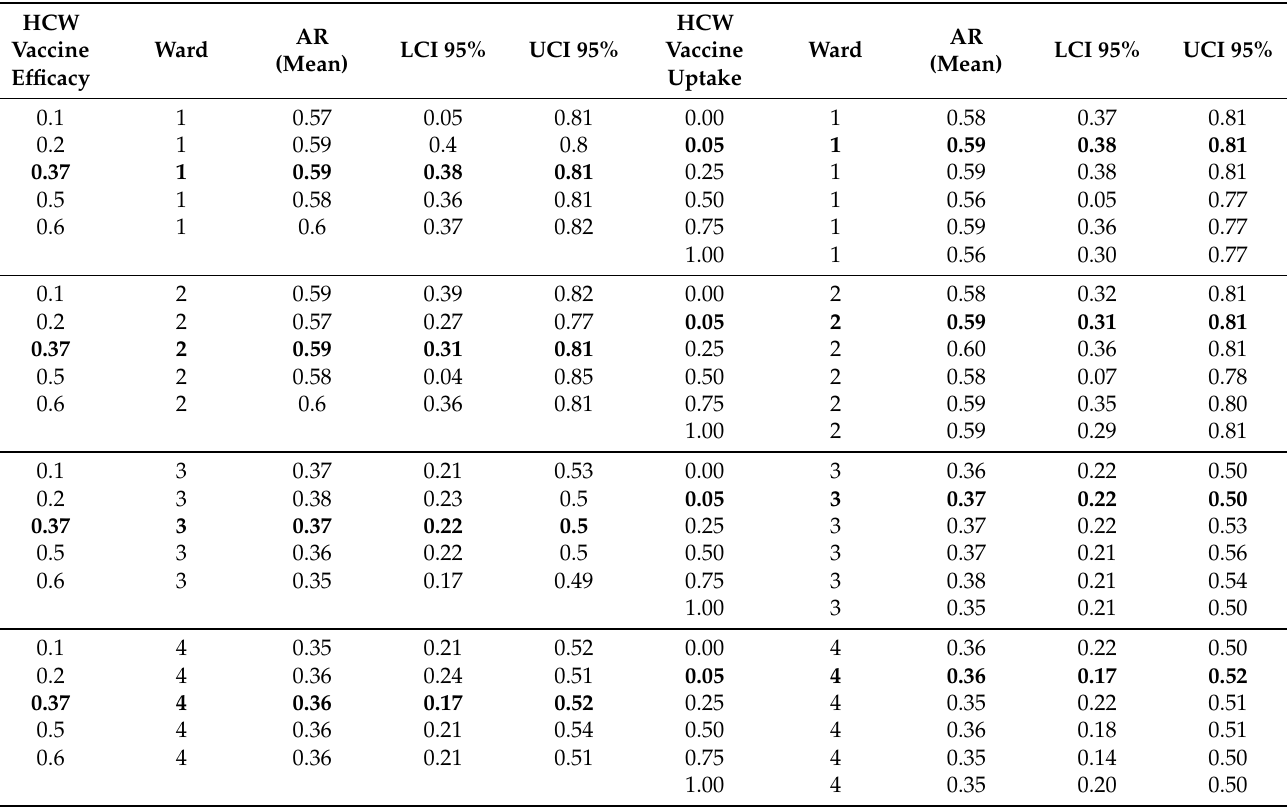
Table 2. Results of the simulations: HCW vaccine efficacy and vaccine uptake parameters. The values belonging to the baseline scenario are reported in bold.